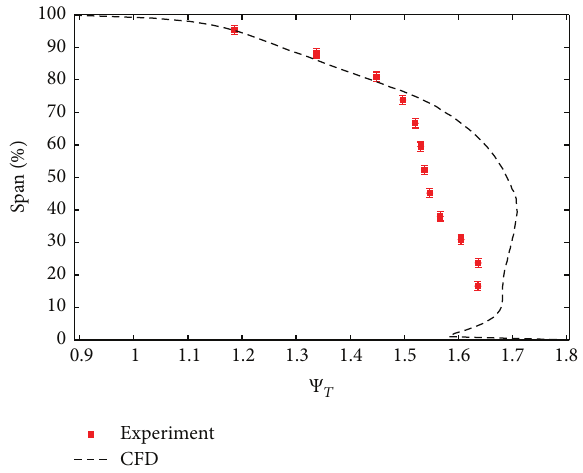
Figure 11: Comparison of measured versus predicted spanwise distribution of nondimensional stagnation pressure downstream of the mixed flow rotor at point 9 in Figure